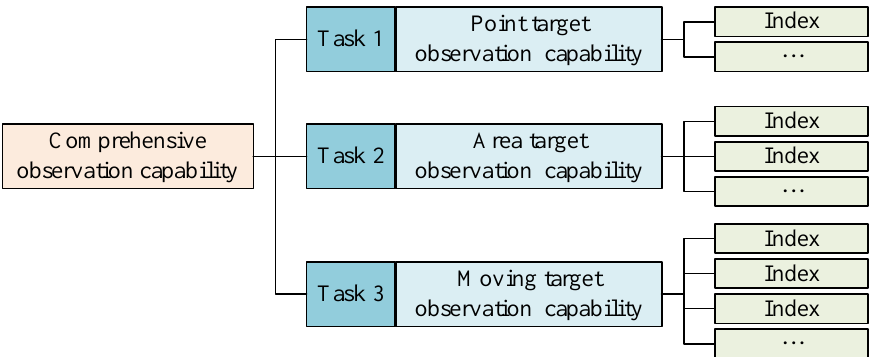
Figure 3. The hierarchy structure of evaluation index system for remote sensing satellites.